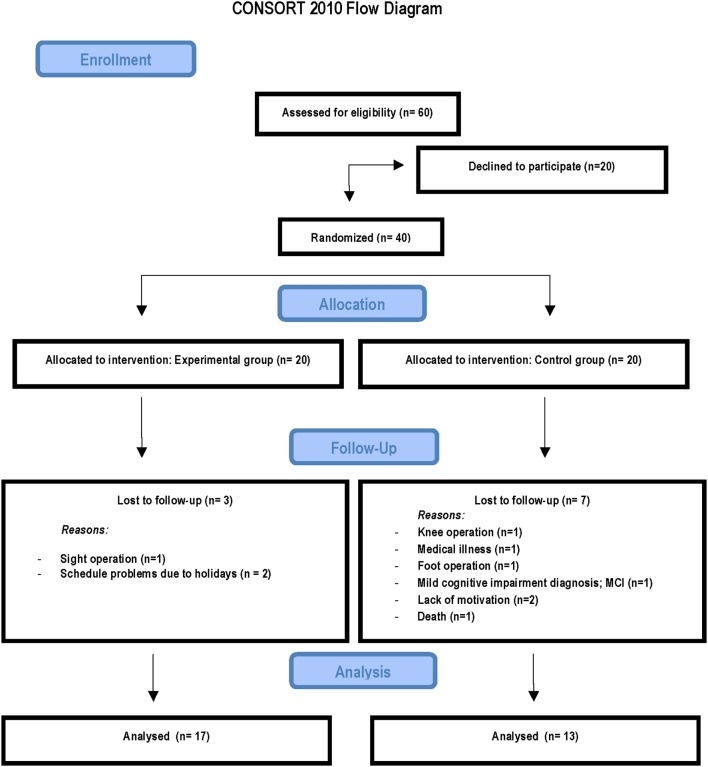
Consort flowchart.